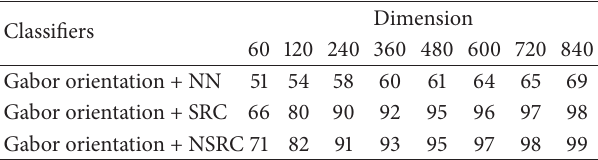
Table 1: The rank one recognition rate for the proposed Gabor orientation feature using three different